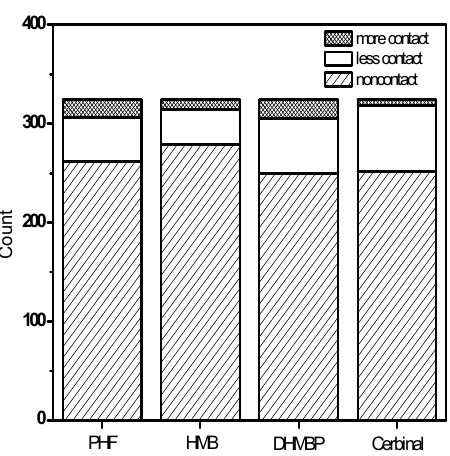
Figure 9. All statistical distribution of atoms in the frequency of contact at PHF, HMB, DHMBP and cerbinal systems.